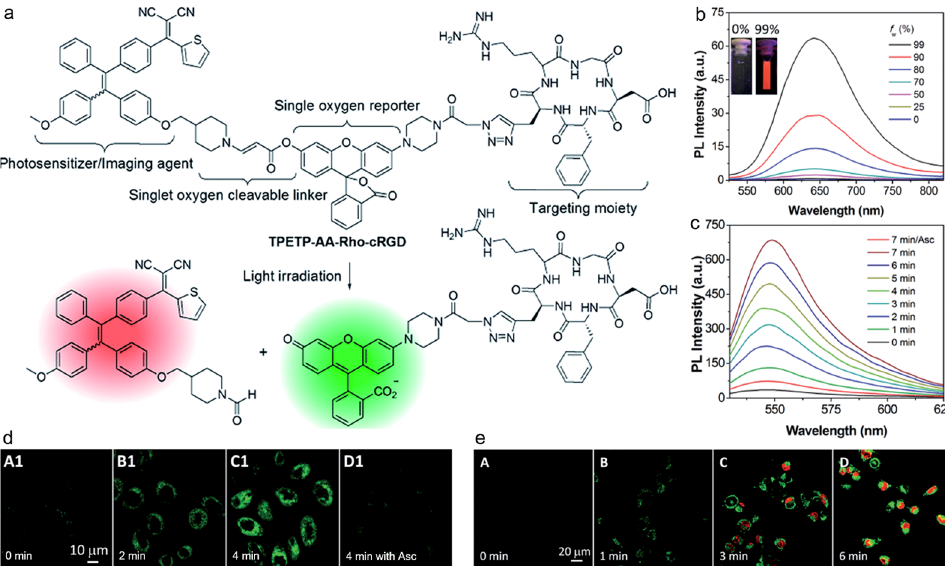
Figure 9. ( a ) Schematic illustration of TPETP-AA-RhocRGD for self-reporting 1 O 2 detection; ( b ) pho- toluminescence of TPETP in DMSO/water mixture with different water fractions; ( c ) photolumines- cence spectra of the probe under light irradiation at different time points; ( d , e ) CLSM images of MDA-MB-231 cells incubated with the probe under light irradiation at different time points as indi- cated. (Reproduced with the permission from ref. [138]. Copyright 2016, The Royal Society of Chem- istry).